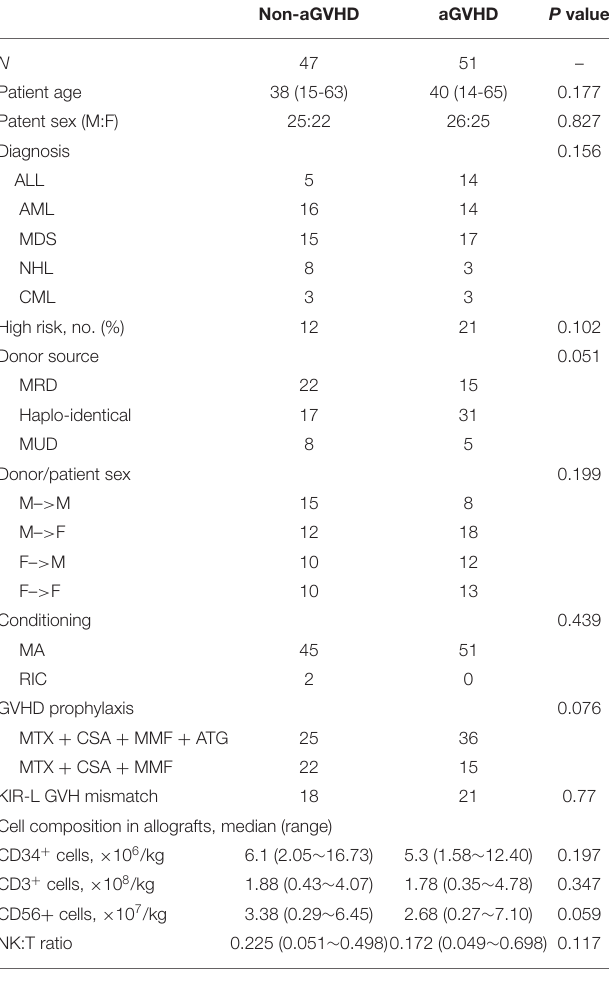
TABLE 1 | Patient, donor, disease, and transplantation characteristics. Non-aGVHD